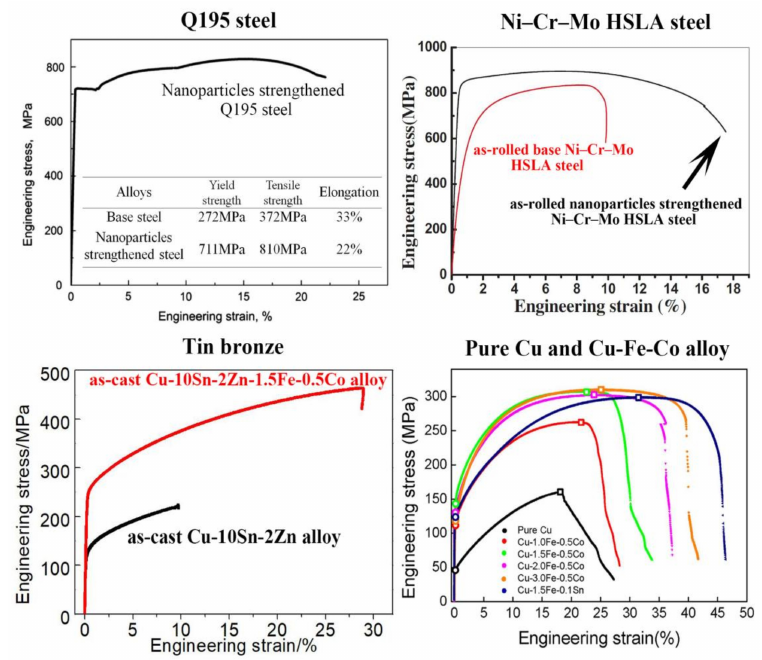
Figure 16. Engineering stress–strain curves of in-situ nanoparticles strengthened alloys compared with each corresponding virgin alloy